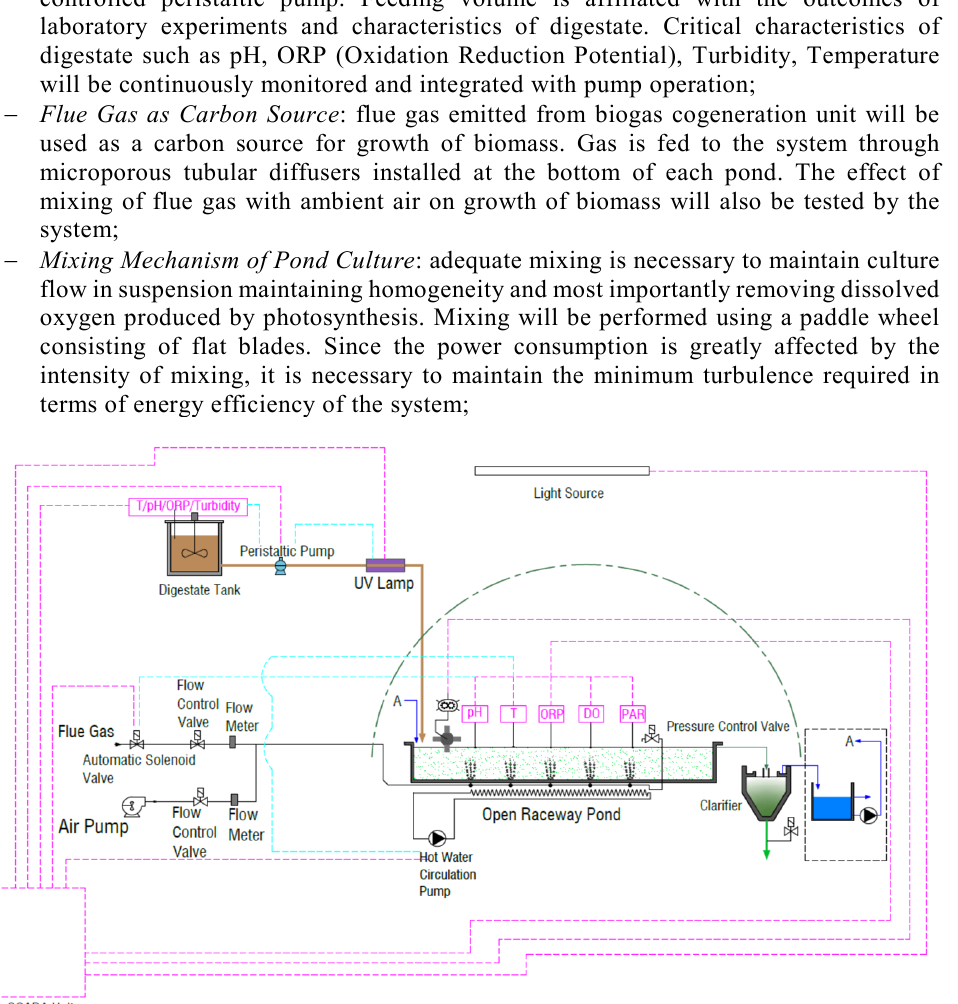
Fig. 3. SMORP technological